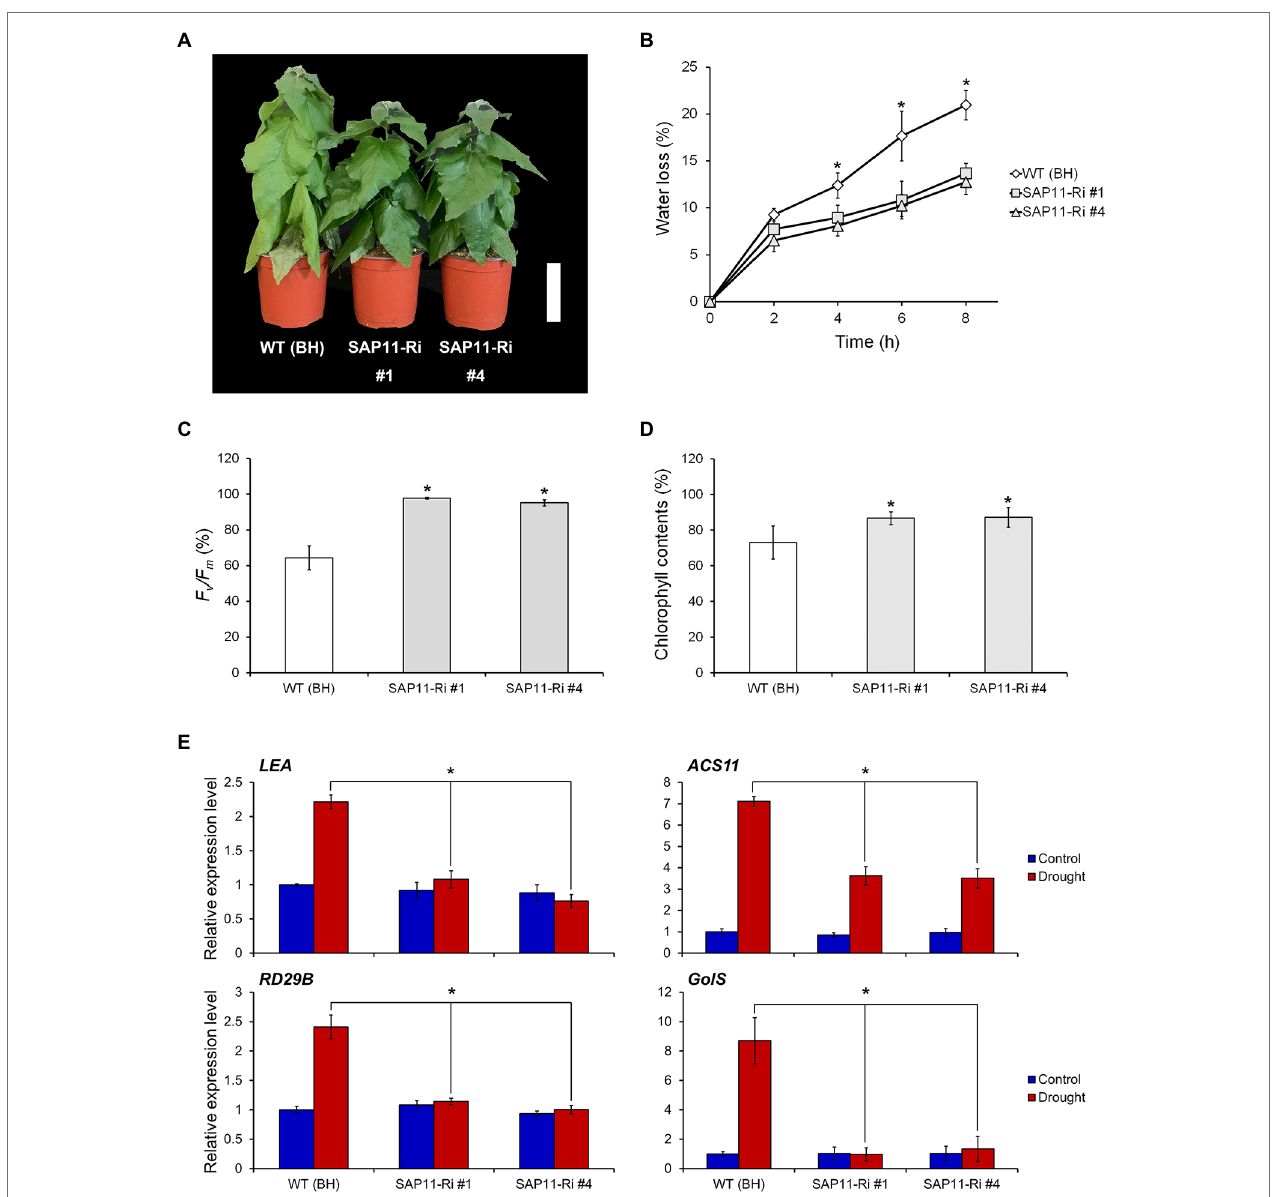
FIGURE 4 | Knockdown of PagSAP11 improves drought tolerance. (A) Phenotype of WT (BH clone) and transgenic poplars (SAP11-Ri #1, #4) after water withdrawal for 10 days. (B-D) Transpirational water loss (B) , photochemical efficiency (C) , and chlorophyll contents (D) were measured in detached leaves from WT and transgenic plants ( n = 5). (E) Expression changes of drought-responsive genes in WT and transgenic poplars after water withdrawal for 3 days. The values represent the means ± standard deviations (SDs) of three biological replicates. Asterisks indicate significant differences by student t -test (* p < 0.05, ** p < 0.005). Scale bar = 10